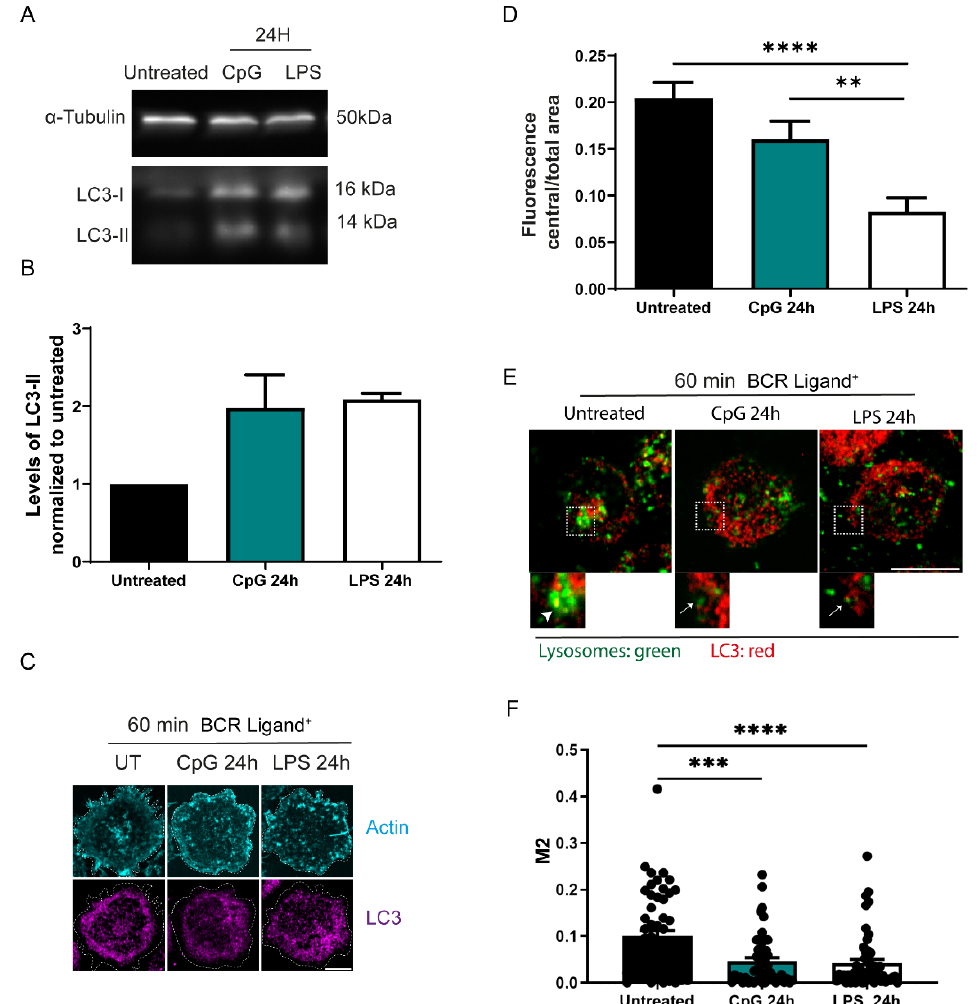
Figure 3. TLR ligands induce autophagy in B cells and affect lysosomal distribution. ( A ) Immunoblot showing levels of LC3-II in control, CpG and LPS pre-treated cells. ( B ) Quantification of the ratio of LC3-II and α -Tubulin from A. N = 3. ( C ) Representative confocal images of control, LPS, and CpG pre-treated B cells activated on antigen-coated coverslips for 60 min and stained for LC3 (magenta) and F-actin, phalloidin (Cyan). ( D ) Quantification of the ratio between the central and total area of the B cell synapse (>38 cells). ** p < 0.01, **** p < 0.0001, N = 3 (>35 cells). One-way ANOVA with Dunnet’s multiple comparison test. ( E ) Confocal images on the synaptic plane showing control, CpG and LPS pre-treated B cells activated at on an antigen-coated coverslip for 60 min and stained for LAMP1 (Green) and LC3 (Red). Insets highlight LAMP1 and LC3 localization in the center or periphery of the immune synapse. Arrowhead shows colocalization of LC3 and LAMP1 near the center of the IS, meanwhile arrows show LC3 and LAMP1 interacting in the periphery of the cell. Scalebar 10 µ m. ( F ) Manders’ coefficient of fraction of lysosomes overlapping with LC3. One-way ANOVA with Dunnet’s multiple comparison test (>50 cells); *** p < 0.001, **** p <